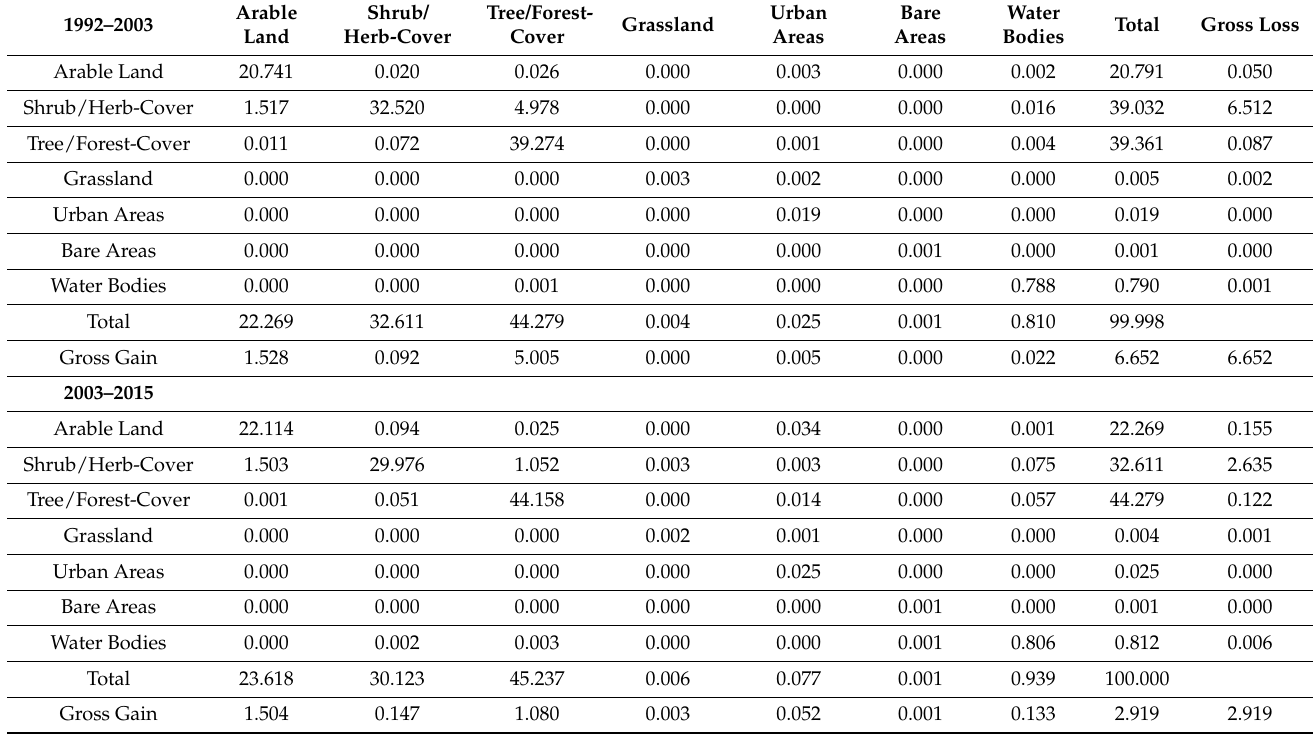
Table 2. Land-cover transition matrix for two time intervals: 1992–2003 and 2003–2015.